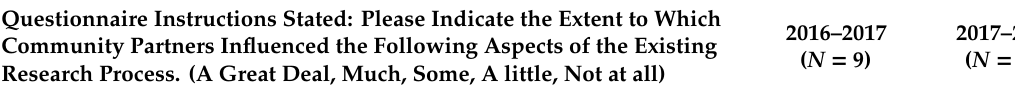
Table 2. Community influence on the research process: Findings from the HHH Partnership Evaluation Questionnaire years 1 and